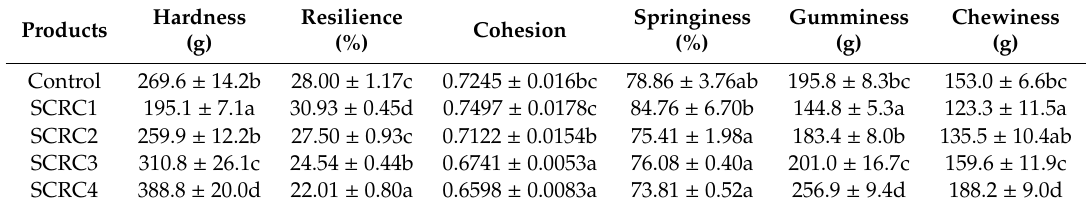
Table 3. E ff ect of Sweet corn residue (SCR) addition on the texture characteristics of cakes.